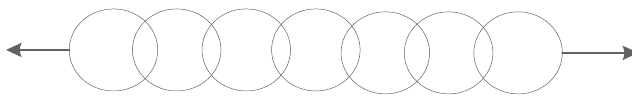
Figure 1. Illustration of the weakest link model.